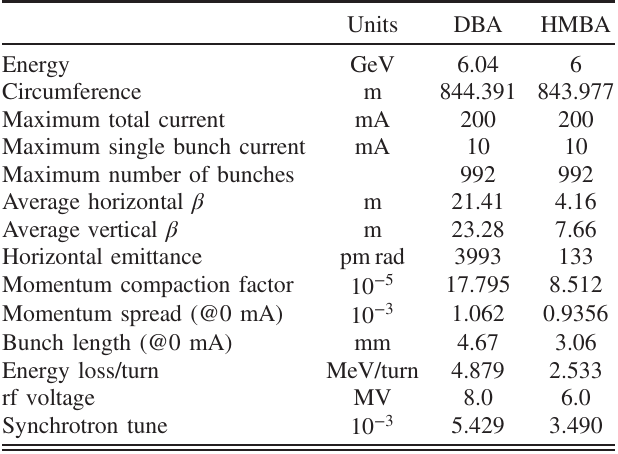
TABLE I. Main design parameters of the ESRF-EBS storage ring.